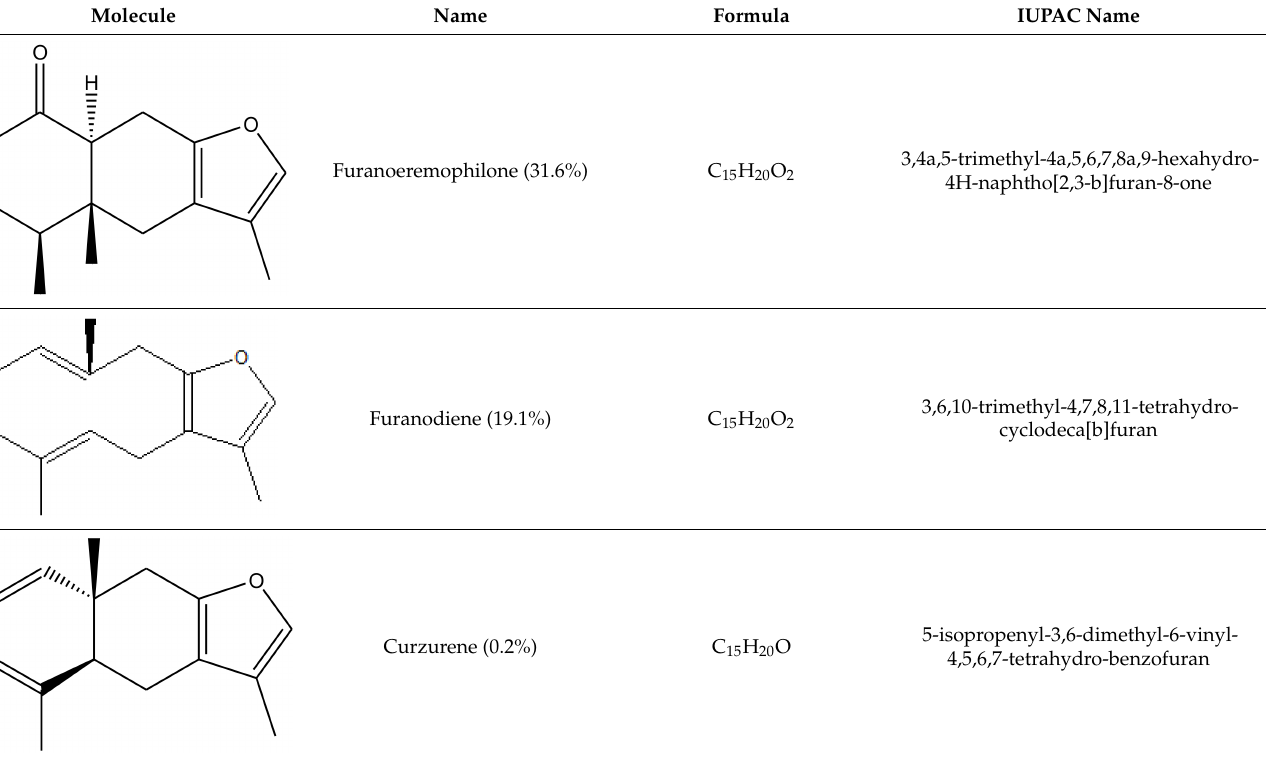
Table 3. Furanoeremophilone and furanodiene+curzurene structures and information.